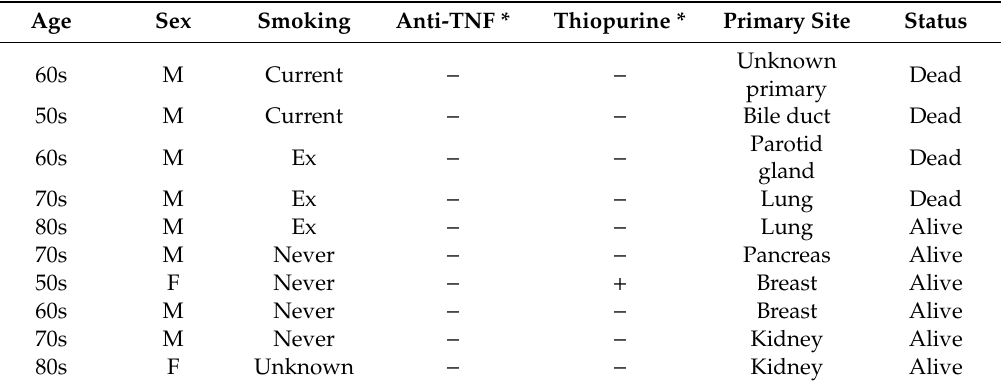
Table 2. Extracolonic malignancies observed after the randomized controlled